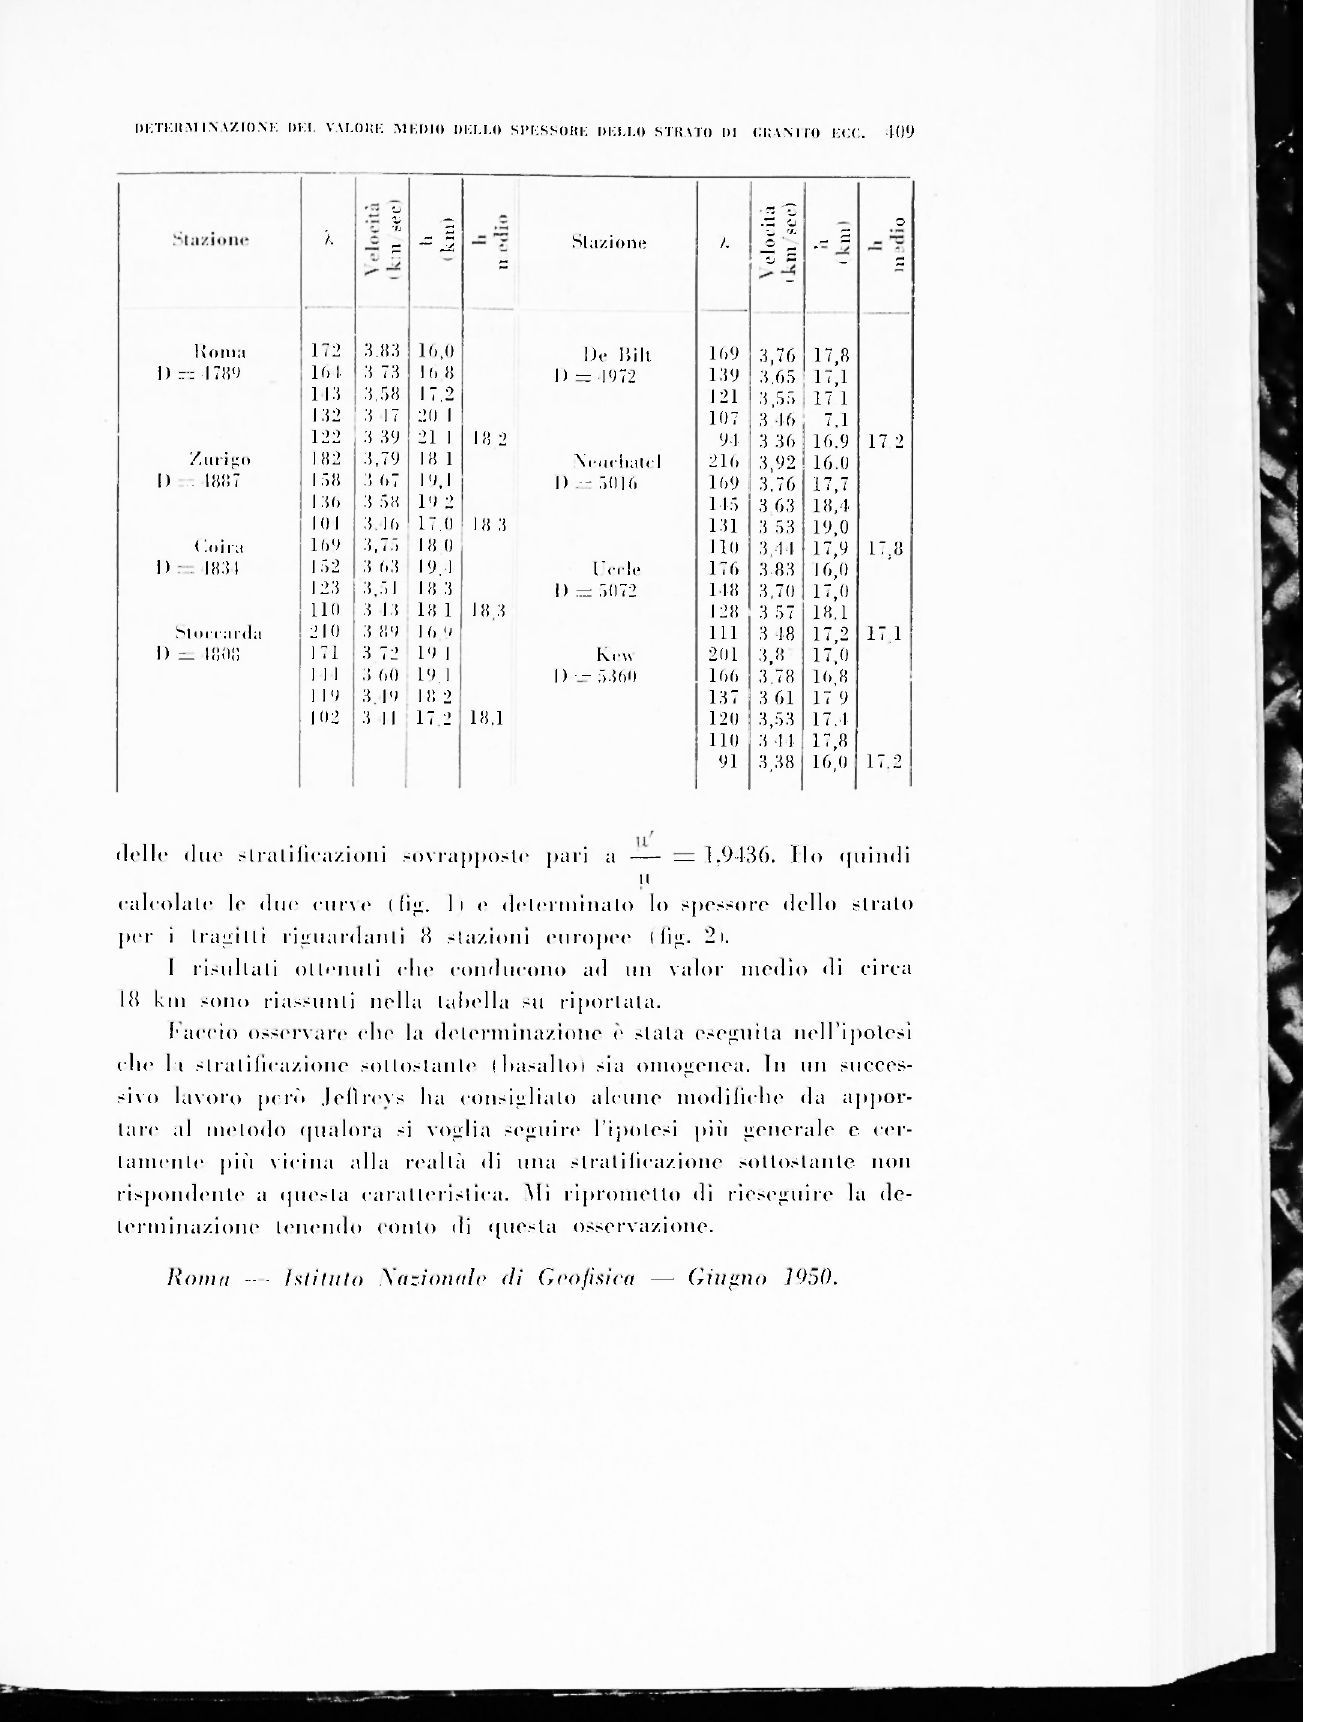
I fig. li e determinato lo spessore dello strato per i tragitti riguardanti 8 stazioni europee I fig.